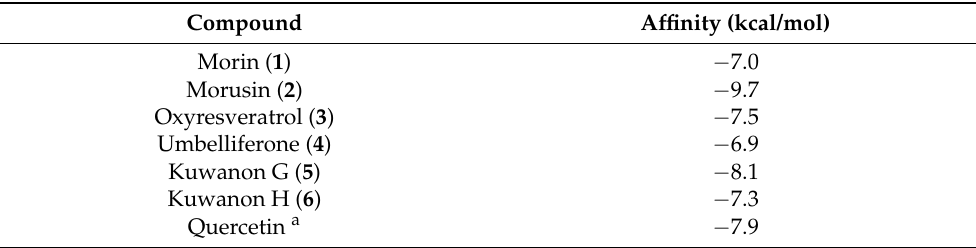
Figure 10. Interaction of quercetin with active sites of Mus musculus iNOS. Table 11. Binding energies of inducible nitric oxide synthase (iNOS) from Mus musculus in